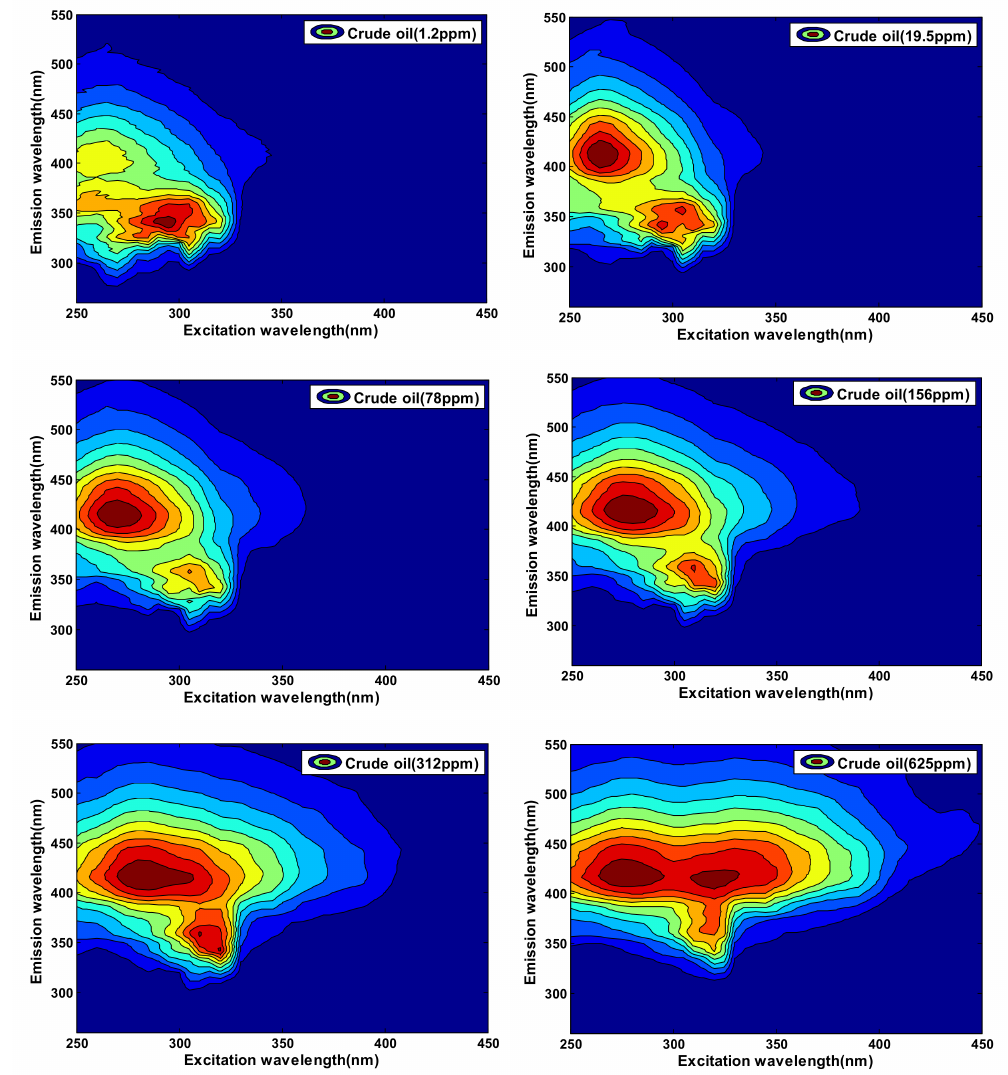
Figure 1. The Excitation Emission Matrix (EEM) spectra obtained from crude oil at concentrations of 1.2 ppm, 19.5 ppm, 78 ppm, 156 ppm, 312 ppm, and 625